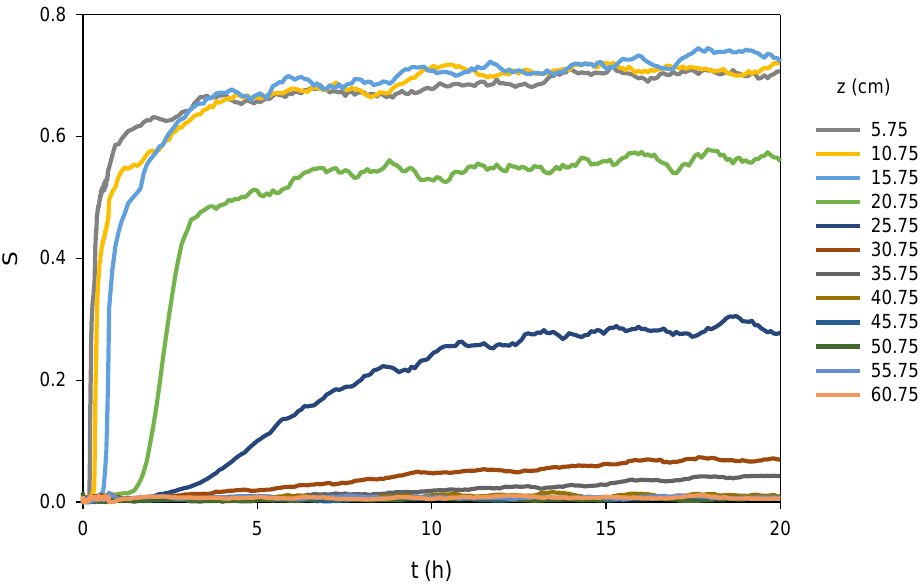
Figure 3. Saturation at the twelve sensors measured over the first 20 h of the imbibition experiment. Sensor elevation (z) is reported from the water table.